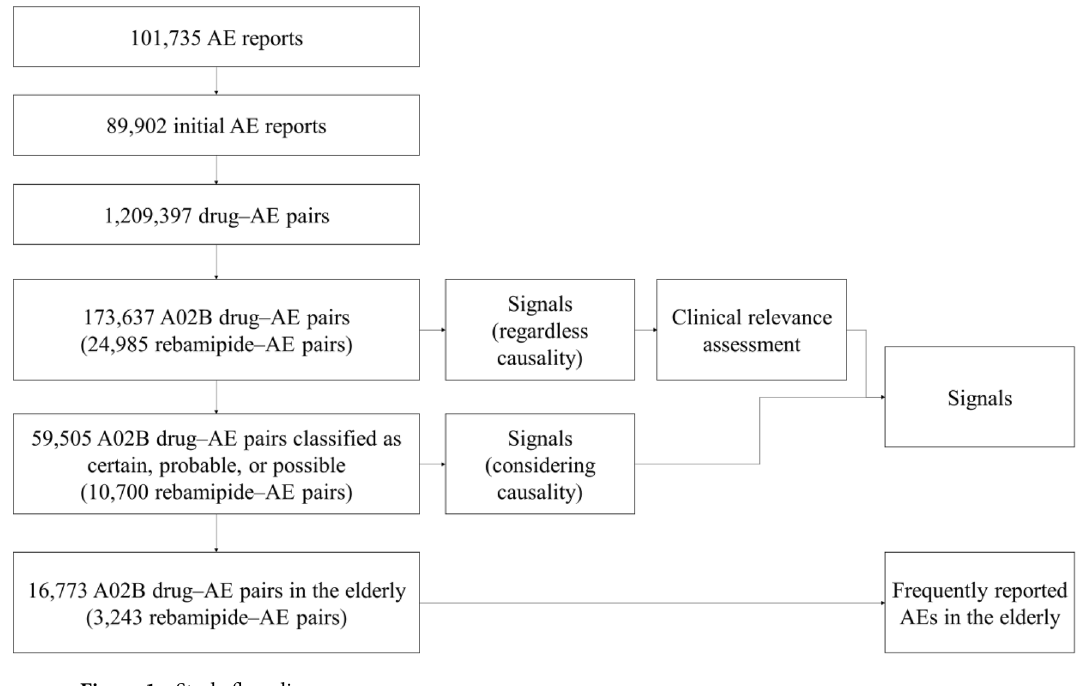
Figure 1. Study flow